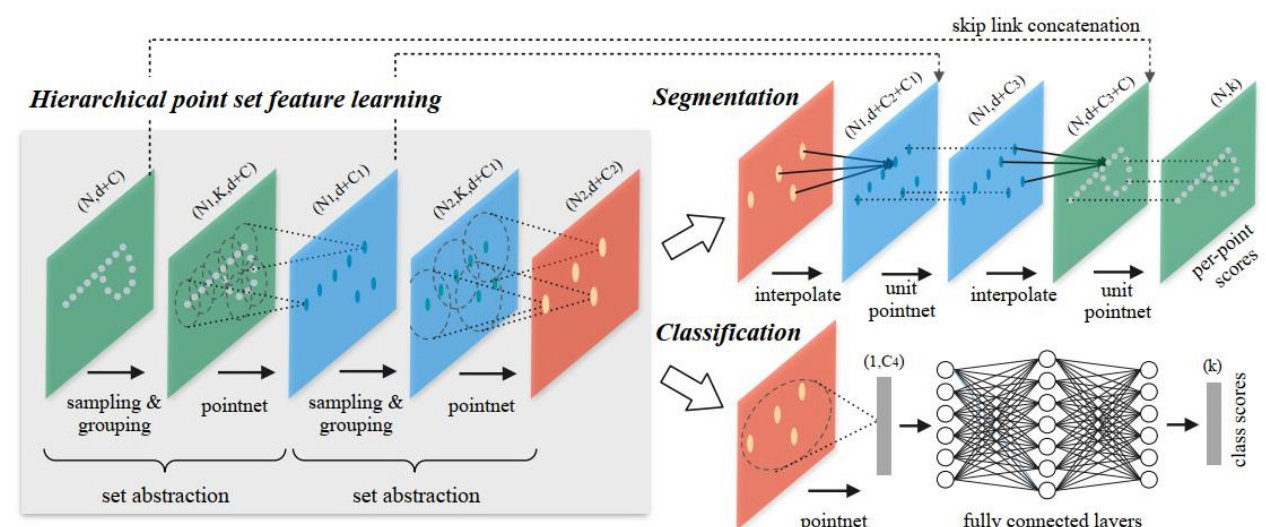
Figure 5. The multilevel architecture of PointNet++. Explicit neighborhood search in the point clouds is used to extract local features by means of a locally applied PointNet in multiple stages. These strong local feature can be used for object classification (lower branch) or for segmentation (upper branch) [23].